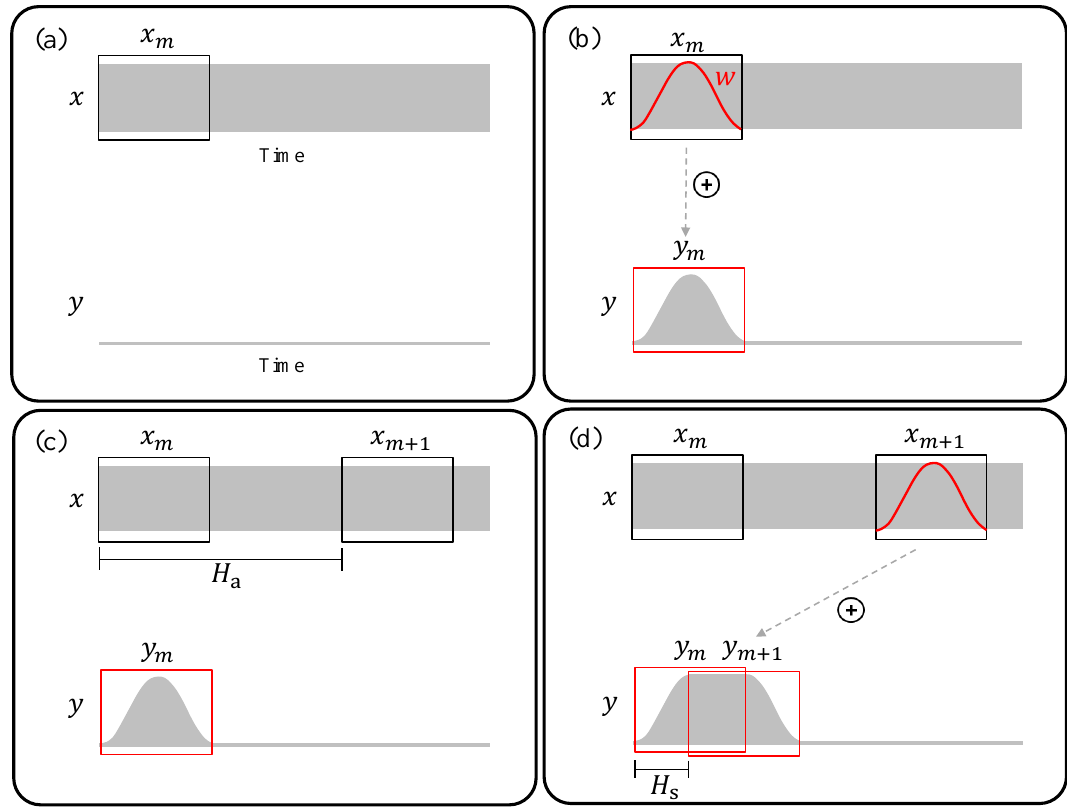
Figure 3. The principle of TSM based on overlap-add (OLA). ( a ) Input audio signal x with analysis frame x m . The output signal y is constructed iteratively; ( b ) Application of Hann window function w to the analysis frame x m resulting in the synthesis frame y m ; ( c ) The next analysis frame x m + 1 having a specified distance of H a samples from x m ; ( d ) Overlap-add using the specified synthesis hopsize H s